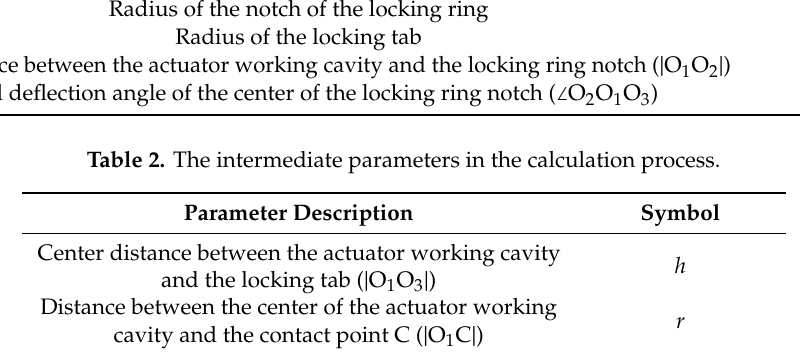
Table 1. The relevant design parameters of the low-power holding mechanism.